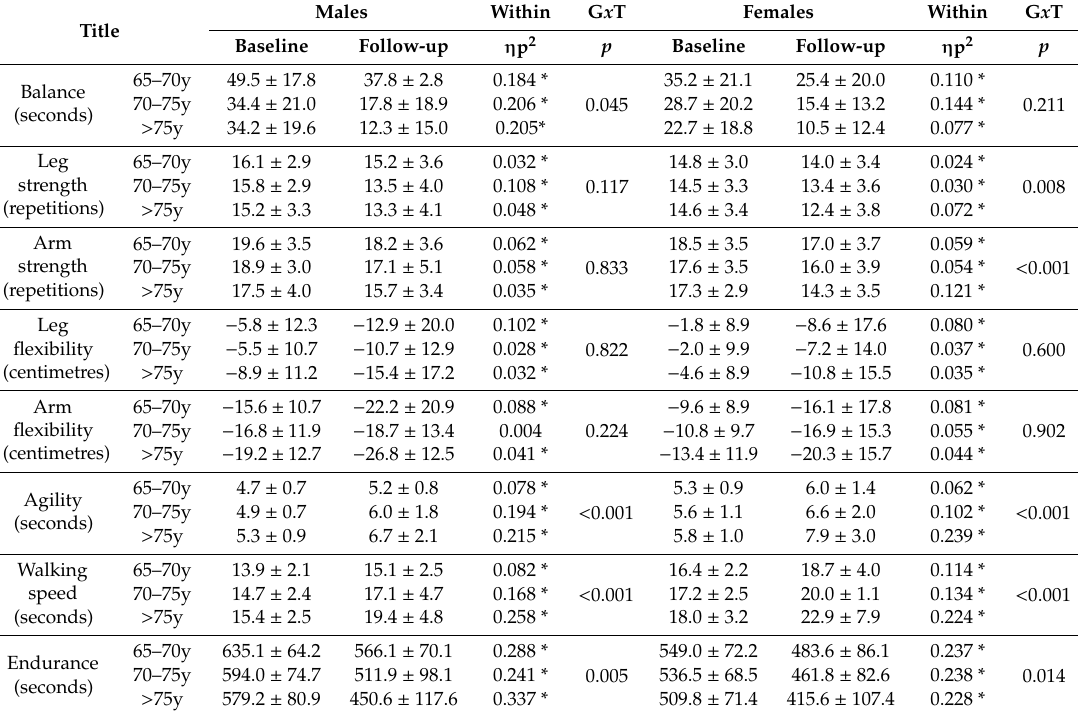
Table 3. Physical performance stratified by age groups.